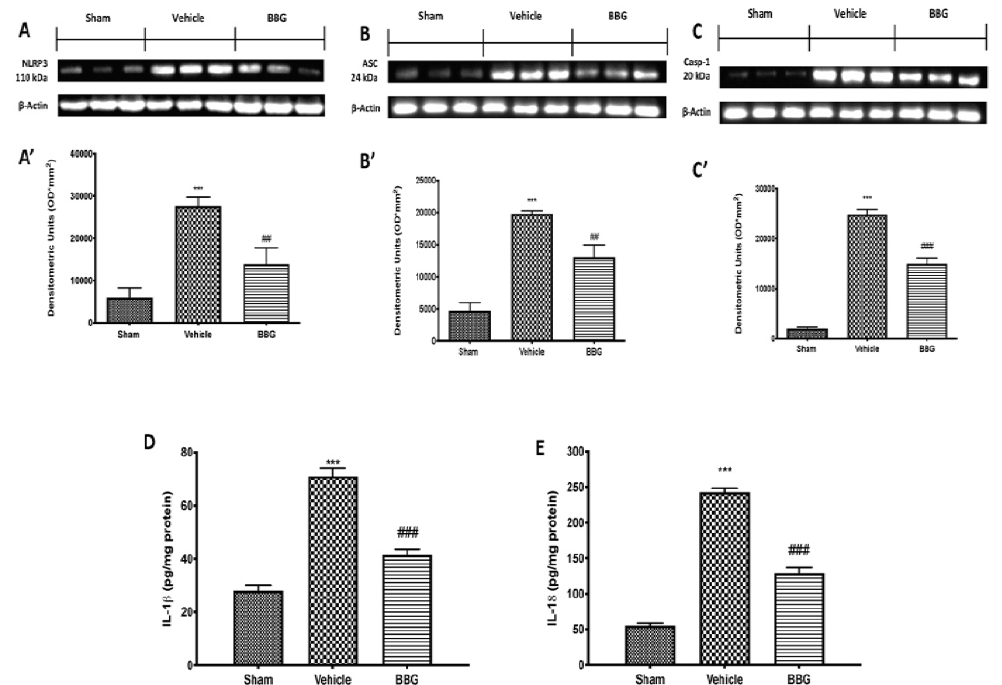
Figure 3. Western blot and respective quantification of NLRP3 ( A , A’ ), ASC ( B , B’ ) and Casp-1 ( C , C’ ) in spinal cord tissue. Cytokines expression: IL-1 β ( D ) and IL-18 ( E ). Data are representative of at least three independent experiments and are expressed as mean ± SEM from N = 6 rats/group. *** p < 0.001 vs. sham; ## p < 0.01 vs. vehicle; ### p < 0.001 vs. vehicle.